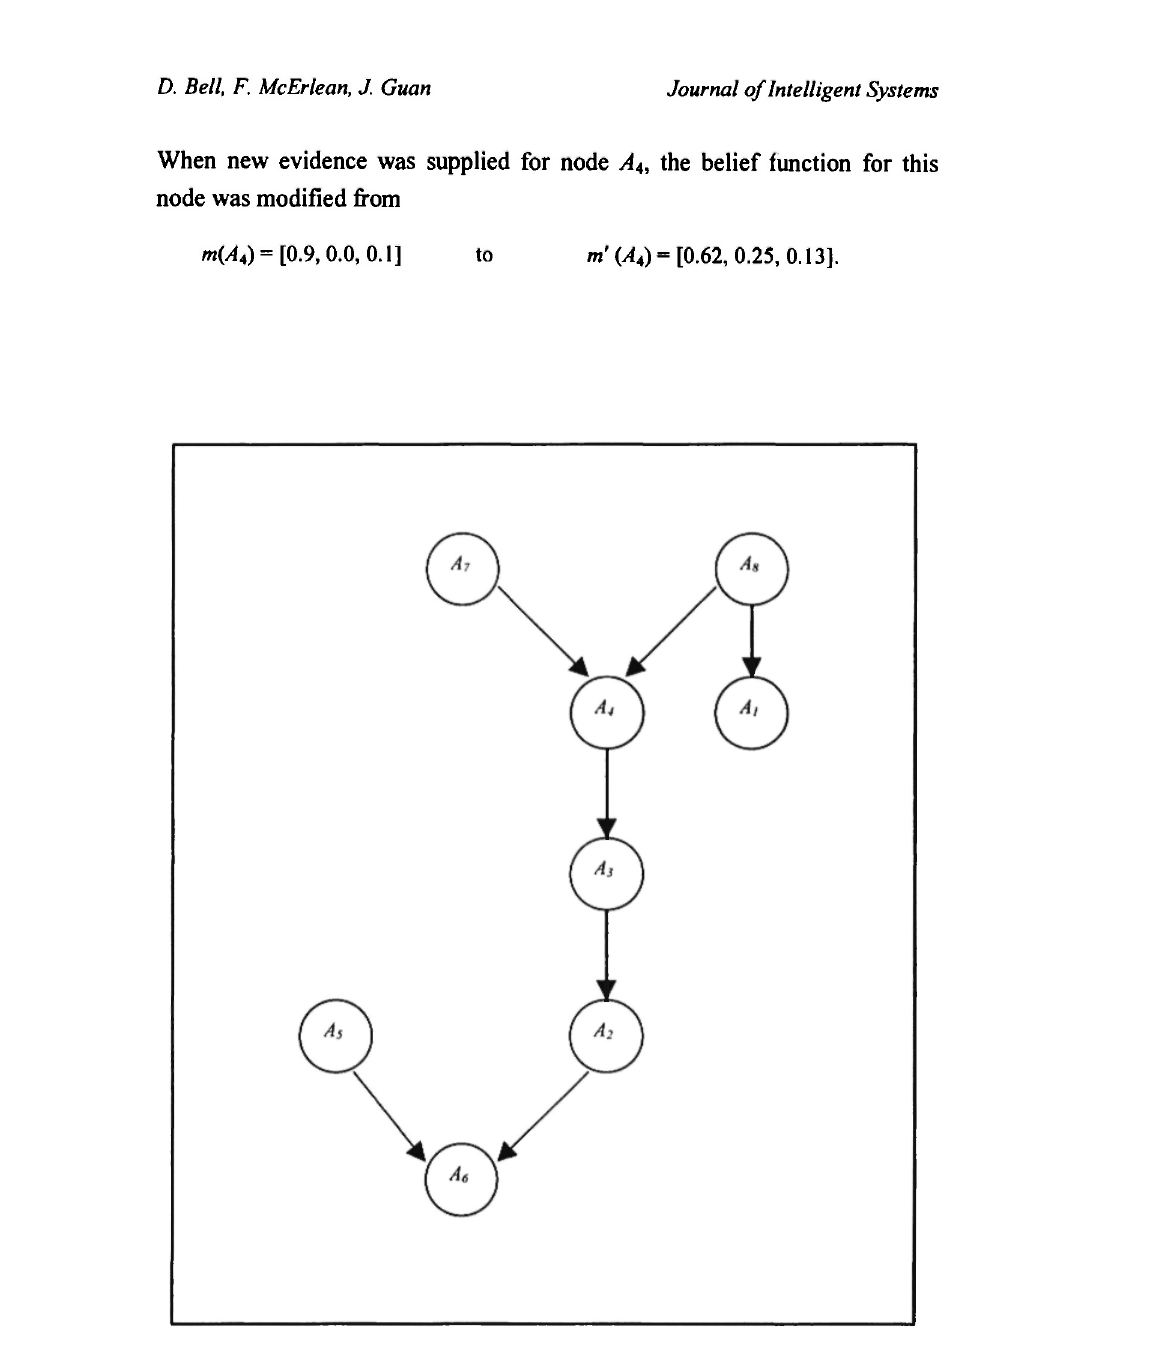
Fig. 12: Optimal causal network structure produced by NETEXTRACT for the NTELECOM